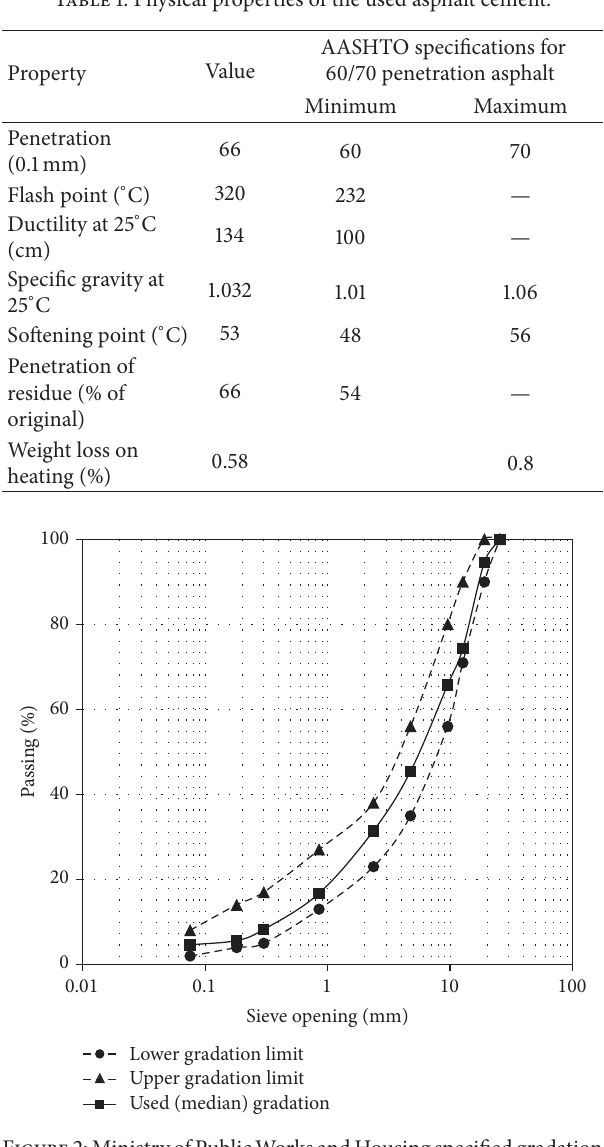
Figure2:MinistryofPublicWorksandHousingspecifiedgradation limits and used gradation.